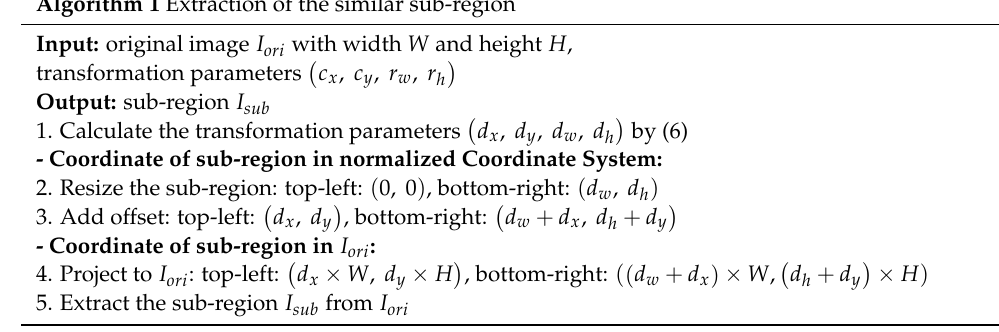
Algorithm 1 Extraction of the similar sub-region